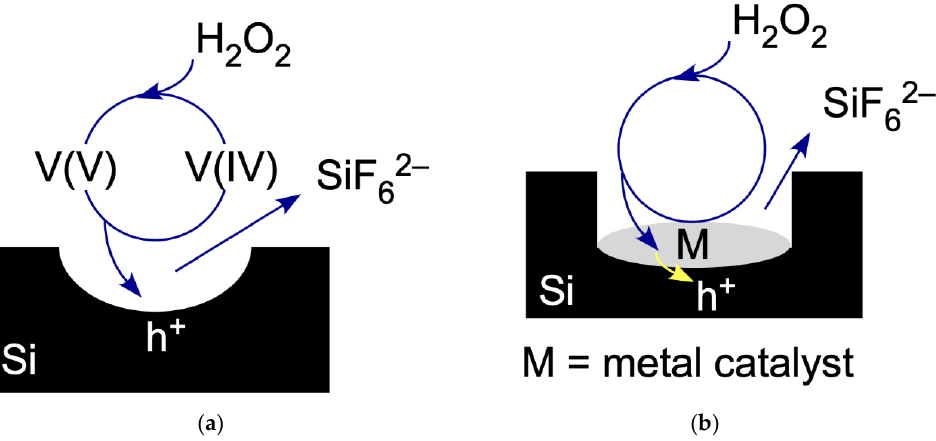
Figure 1. ( a ) The ReEtch cycle for etching of Si. An oxovanadium ion with vanadium in +5 oxidation state, denoted V(V), injects a hole, h + , in the Si valence band and is reduced to a vanadium ion in +4 oxidation state, V(IV). The hole initiates etching of Si atoms to form a pore in the substrate. The product of the complete reaction is SiF 62– . Injected H 2 O 2 removes an electron from V(IV) to regenerate V(V) so that the cycle can begin again. ( b ) The injection MACE cycle for etching Si, denoted iMACE. Injected H 2 O 2 removes an electron from a metal nanoparticle, M, which then injects a hole into the Si substrate. The hole initiates the etching of Si forming the etch product SiF 62– , to form a pore in the substrate.